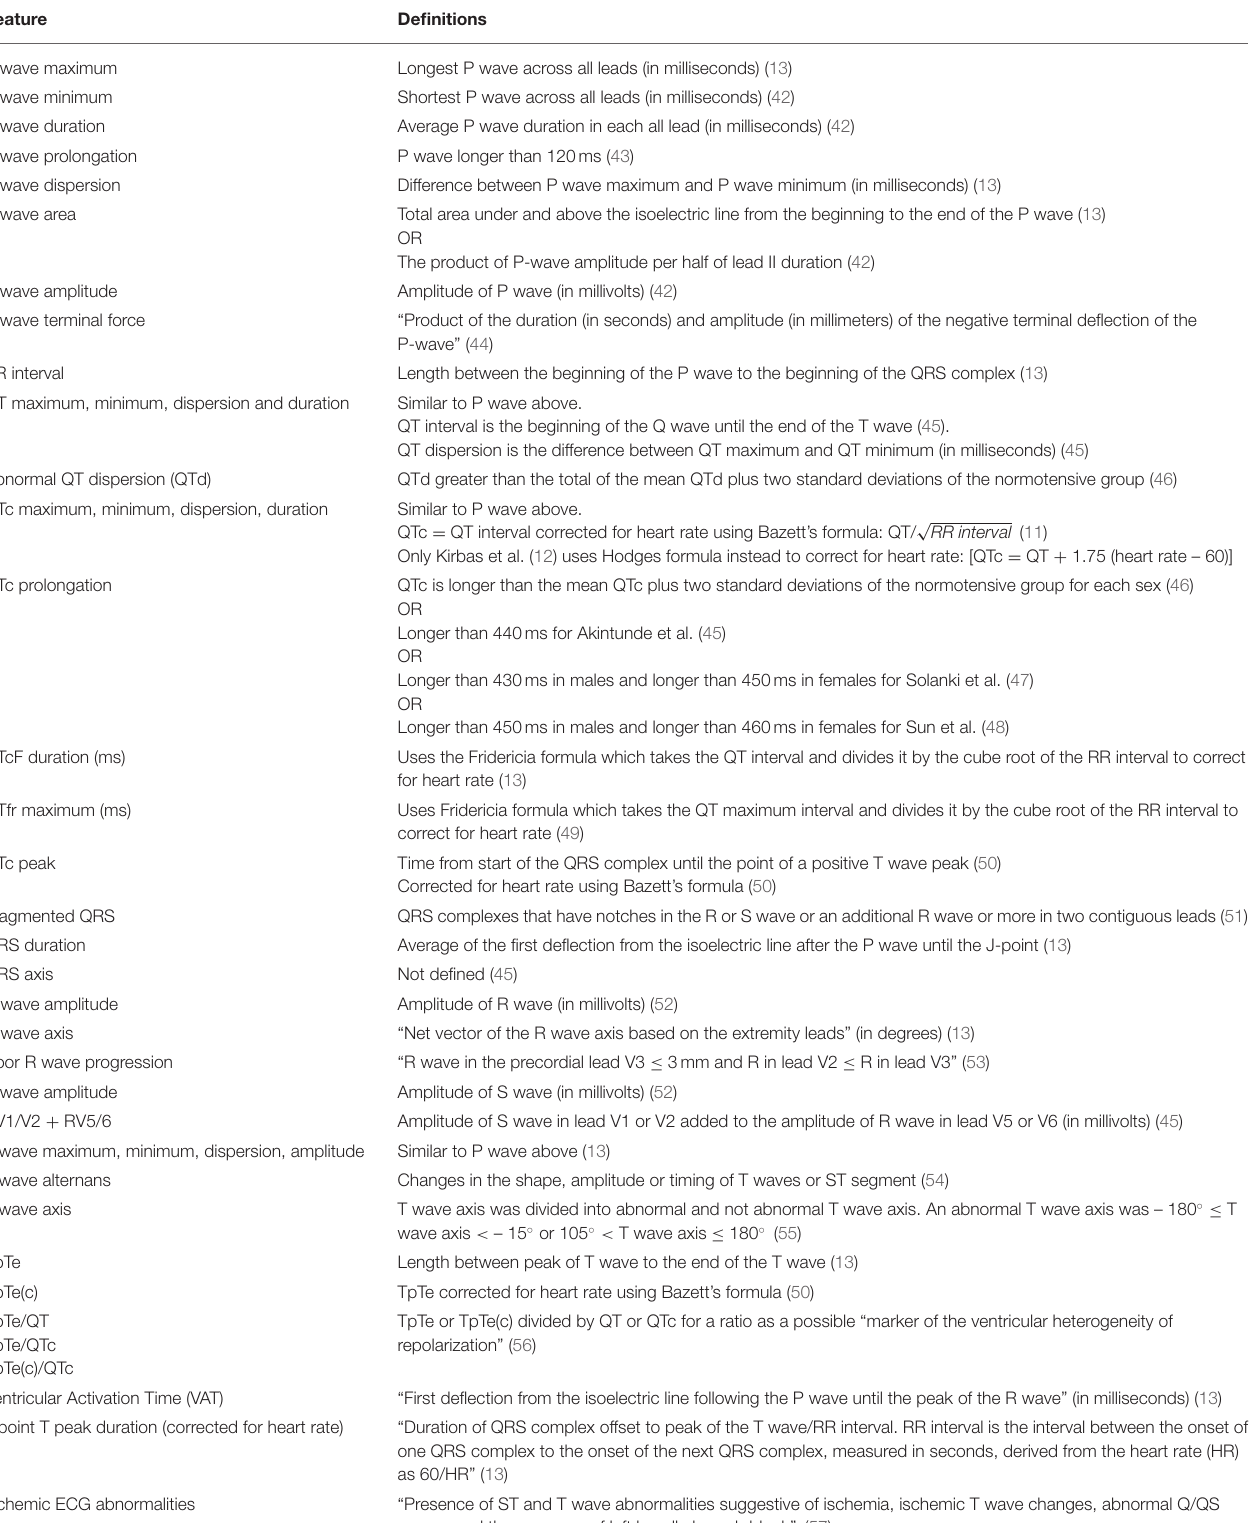
TABLE 1 | Summary of ECG wave morphology parameter